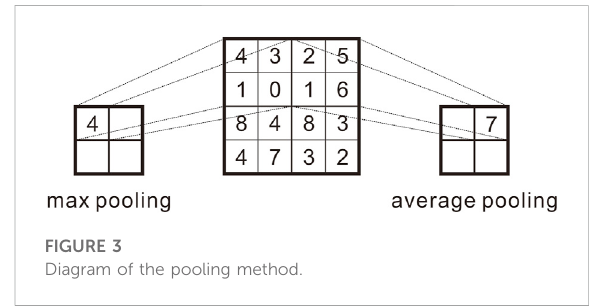
FIGURE 3 Diagram of the pooling method.